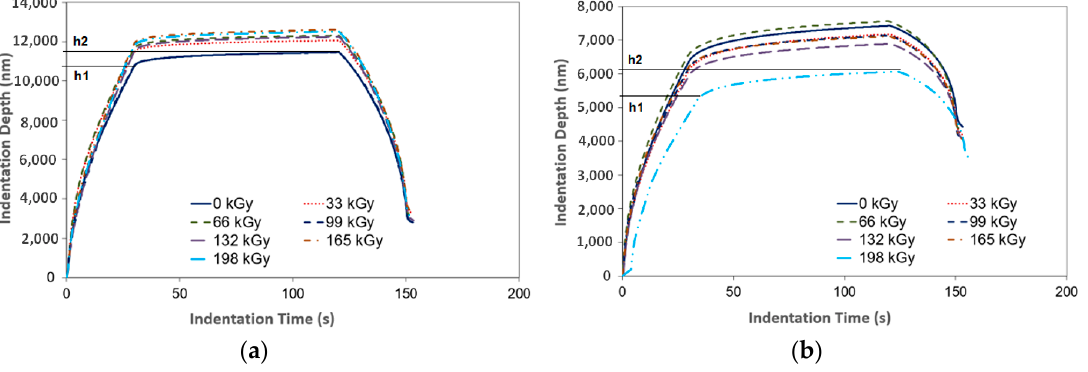
Figure 6. Indentation creep (indentation depth vs. indentation time): ( a ) LDPE; ( b ) HDPE